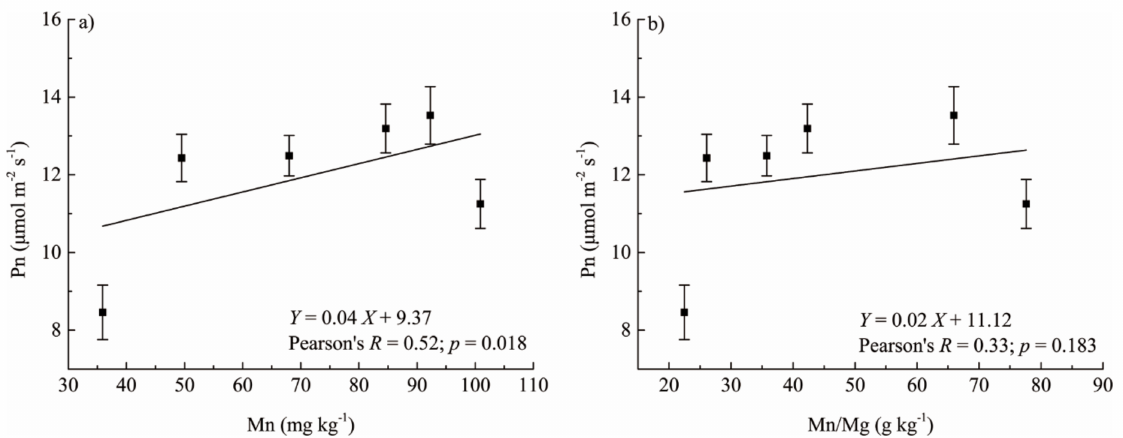
Figure 4. Relationships between the net photosynthesis rate (Pn, a ) and foliar Mn ( b ) concentration, and Mn/Mg ratio for Cupressus lusitanica Mill. Symbols represent the mean ( ± SE) values of Pn for the three replicate composites at a given nitrogen treatment.